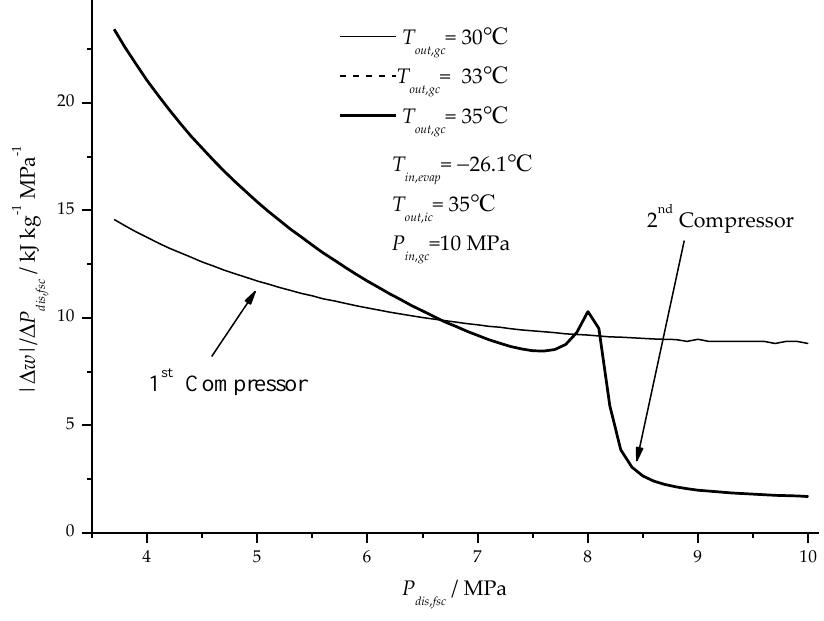
Figure 15. Variations of 1st and 2nd specific compression work at various gas cooler outlet temperatures.